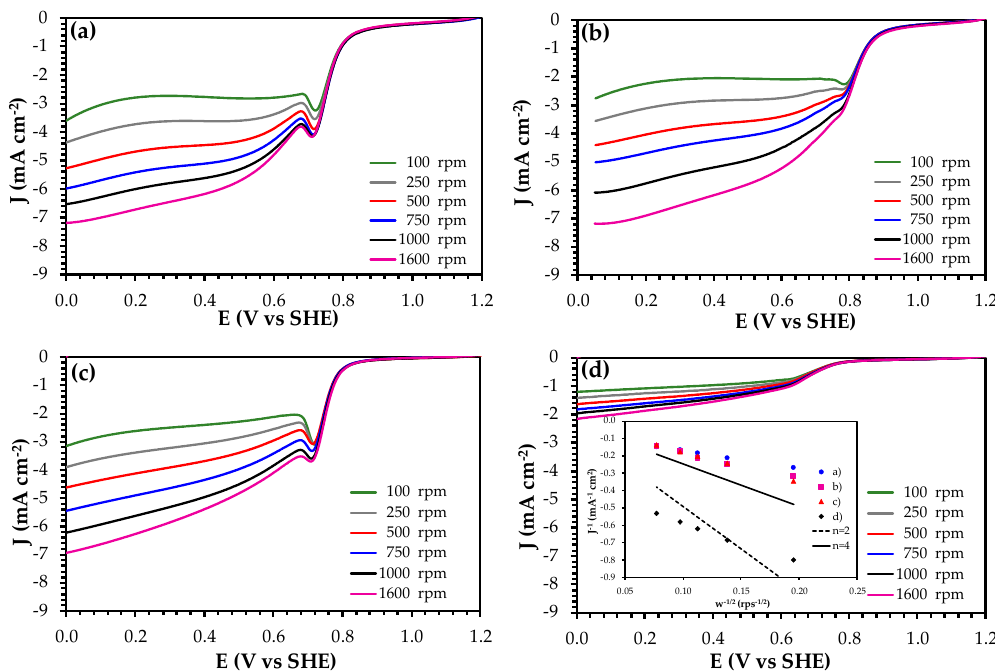
Figure 3. Linear voltammograms of ( a ) (PtPd / rGO) + (PtPd / MWCNT), ( b ) PtPd / (rGO:MWCNT), ( c ) PtPd / MWCNT, and ( d ) PtPd / rGO (inset: comparison of Koutecky–Levich plots at 0.2 V versus a standard hydrogen electrode (SHE) for all electrocatalysts) recorded in O2-saturated H2SO4 (0.5 M) at 5 mV · s − 1 and different rotation rates.